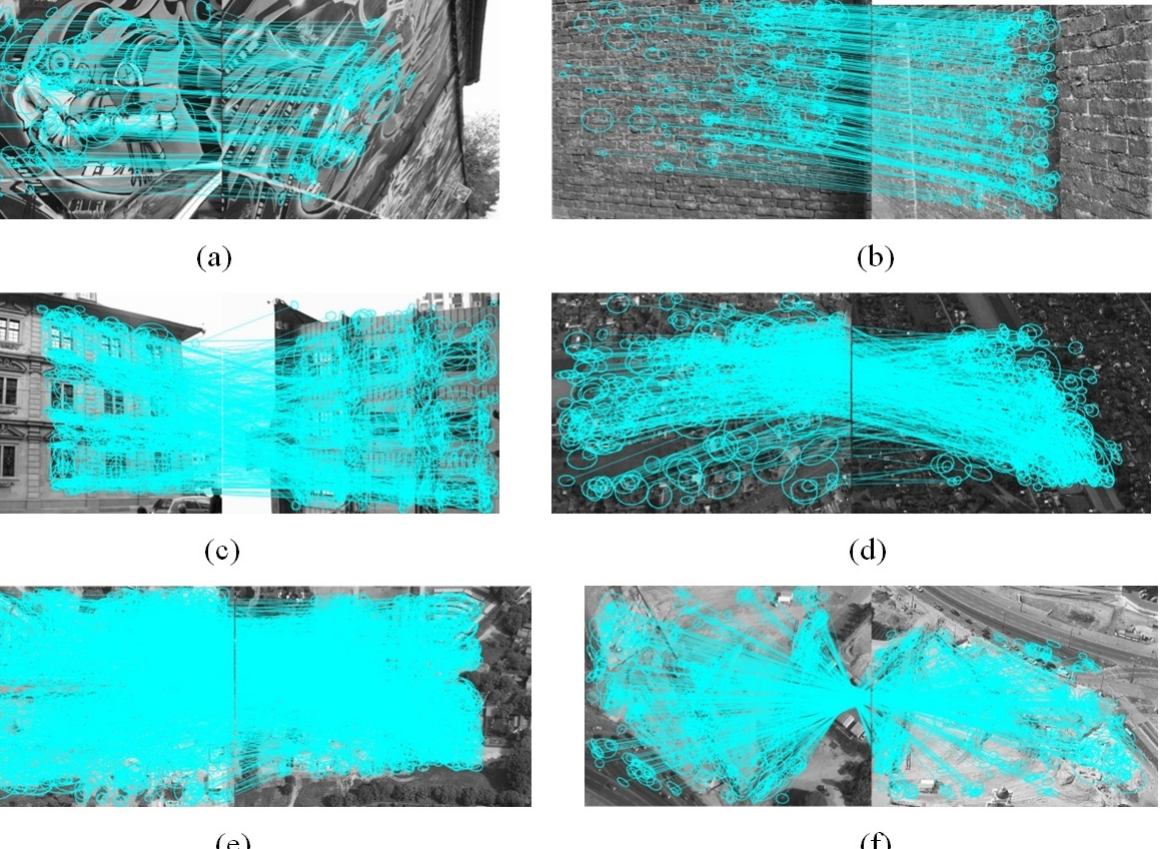
Figure 9. ( a )–( f ) Red points show the matching results of the proposed method with groups of stereo images. The yellow lines represent the epipolar lines estimated from matching points.